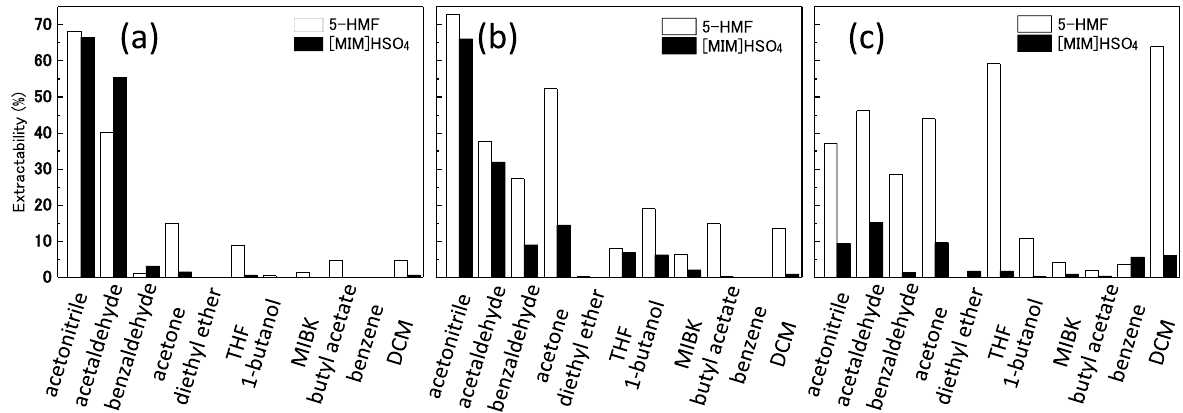
Figure 4. Extraction yields of 5-HMF from ( a ) reaction medium, ( b ) a mixture of [MIM]HSO 4 /water (1/1, v/v), and ( c ) a mixture of [MIM]HSO 4 /ethanol (1/1, v/v) by organic solvent. Extraction was performed on 50 μL of the reaction medium, a mixture of [MIM]HSO 4 /water (1/1, v/v), and a mixture of [MIM]HSO 4 / ethanol (1/1, v/v) with 500 μL of organic solvent. THF tetrahydrofuran, MIBK methyl isobutyl ketone, DCM dichloromethane.